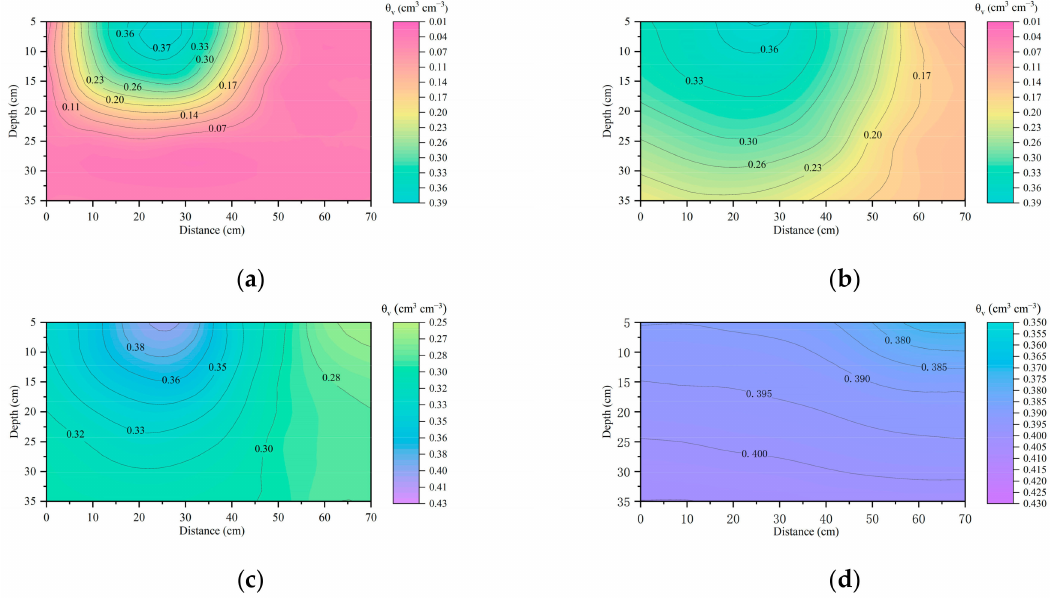
Figure 4. Simulated contours of soil water content under W1: ( a ) The middle of first irrigation; ( b ) the middle of third irrigation; ( c ) the middle of fifth irrigation; ( d ) at the end of experiment.